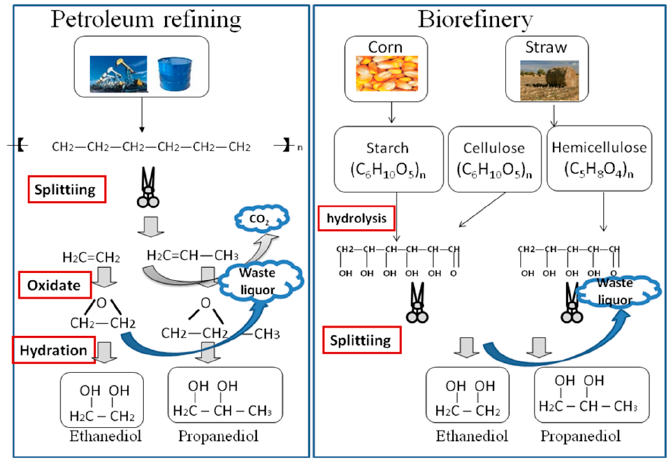
Figure 1. Petroleum refining and biorefinery to produce polyols [9].